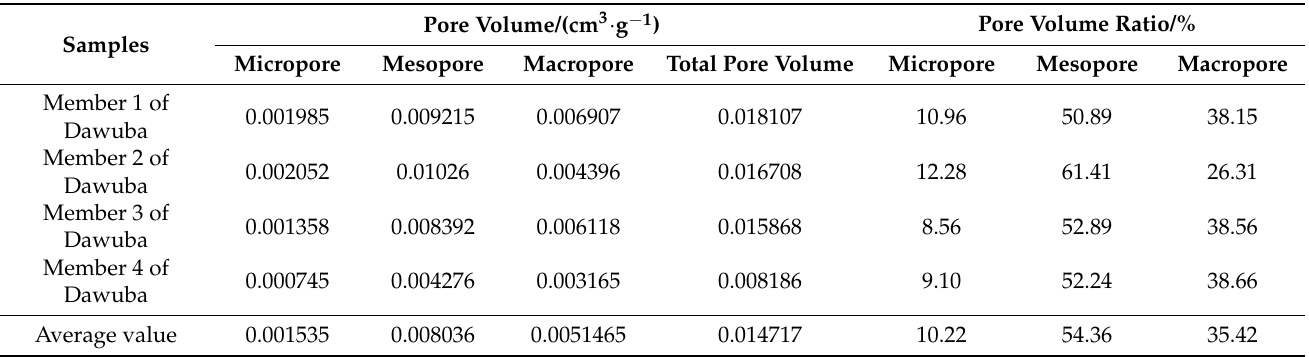
Figure 8. Distribution of specific surface area and full aperture of Dawuba Formation shale in the Qianxi area. ( a ) Member 1 of the Dawuba Formation; ( b ) member 2 of the Dawuba Formation; ( c ) member 3 of the Dawuba Formation; ( d ) member 4 of the Dawuba Formation. Table 3. Statistics of specific surface area of Dawuba Formation shale in the Qianxi